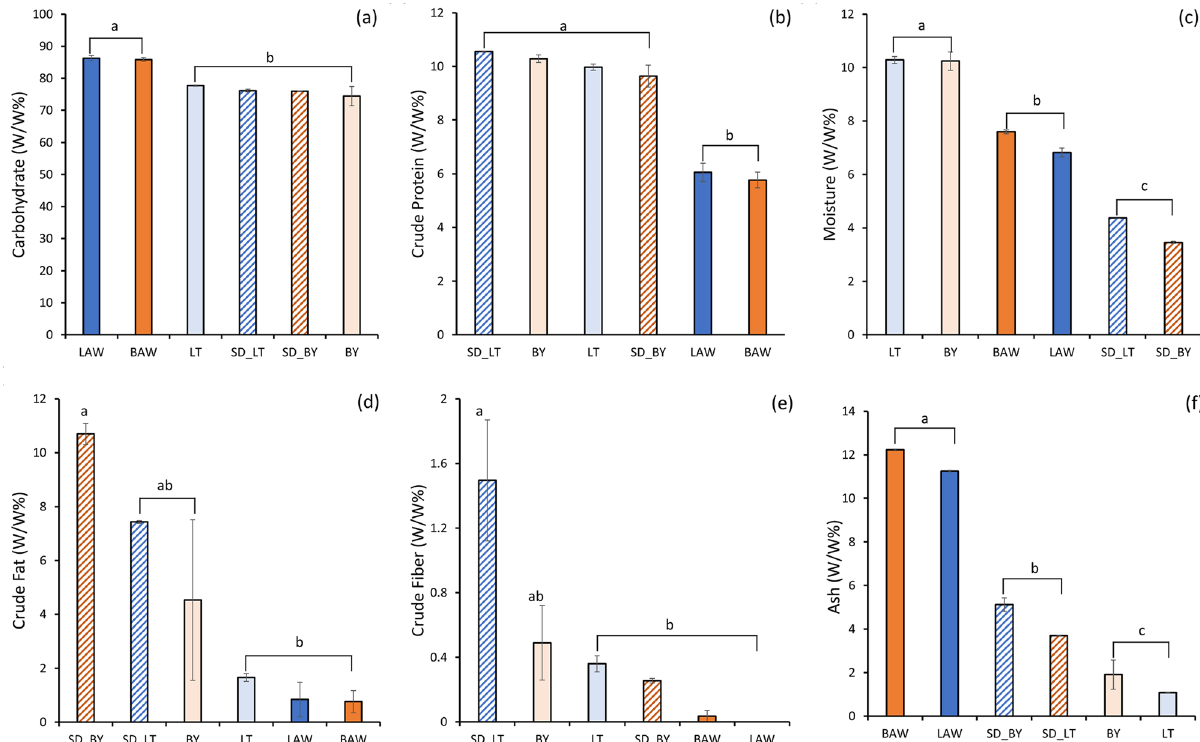
Figure 3. Proximate analysis of millet flours and acid whey millet powders ( a ) carbohydrate ( b ) crude protein ( c ) moisture ( d ) crude fat ( e ) crude fiber ( f ) ash. Mean values followed by different letters are significantly different ( p < 0.05). Legend: Proximate analysis of powder samples. BY: plain Barnyard millet flour; LT: plain Little millet flour; SD_BY: spray dried Barnyard millet soluble fraction; SD_LT: spray dried Little millet soluble